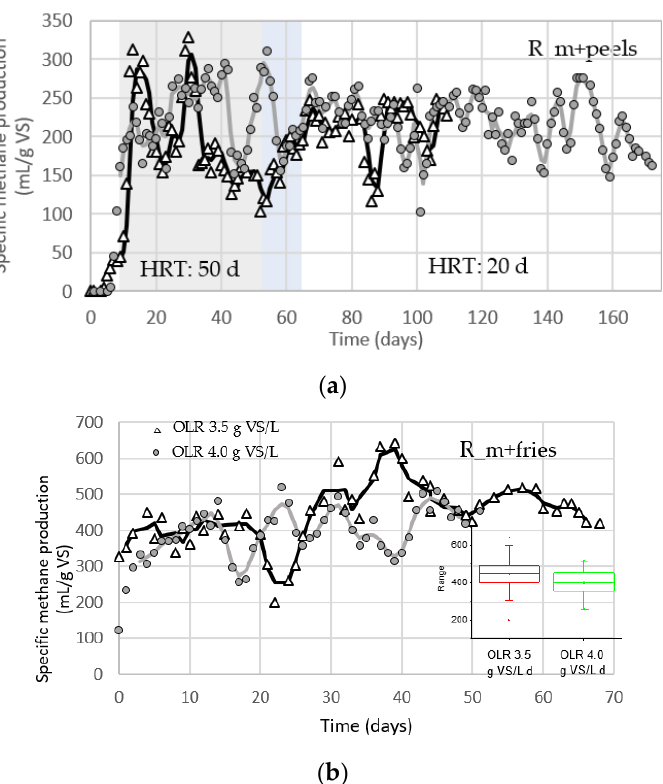
Figure 6. Evolution of specific methane production obtained from semi-continuous reactors treating ( a ) sheep manure and potato peel waste (R_m + peels) and ( b ) sheep manure and discarded chips (R_m + fries).